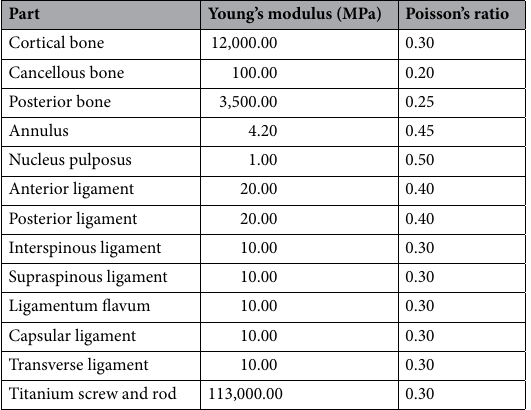
Figure 4 indicated biomechanical test data in vitro and simulation results of four well- validated FE models in the literature were used for the comparison. The comparison of ROM between this intact FE model and previously published data under the combined flexion, extension, left–right lateral bending and left–right axial rotation modes were summarized. There were no obvious differences in the ROM between the intact FE model and the data published by the literature. Because all the data were conformed through normal human body parameters, the intact FE model could simulate the physiological movement of L1–S1 vertebrae.